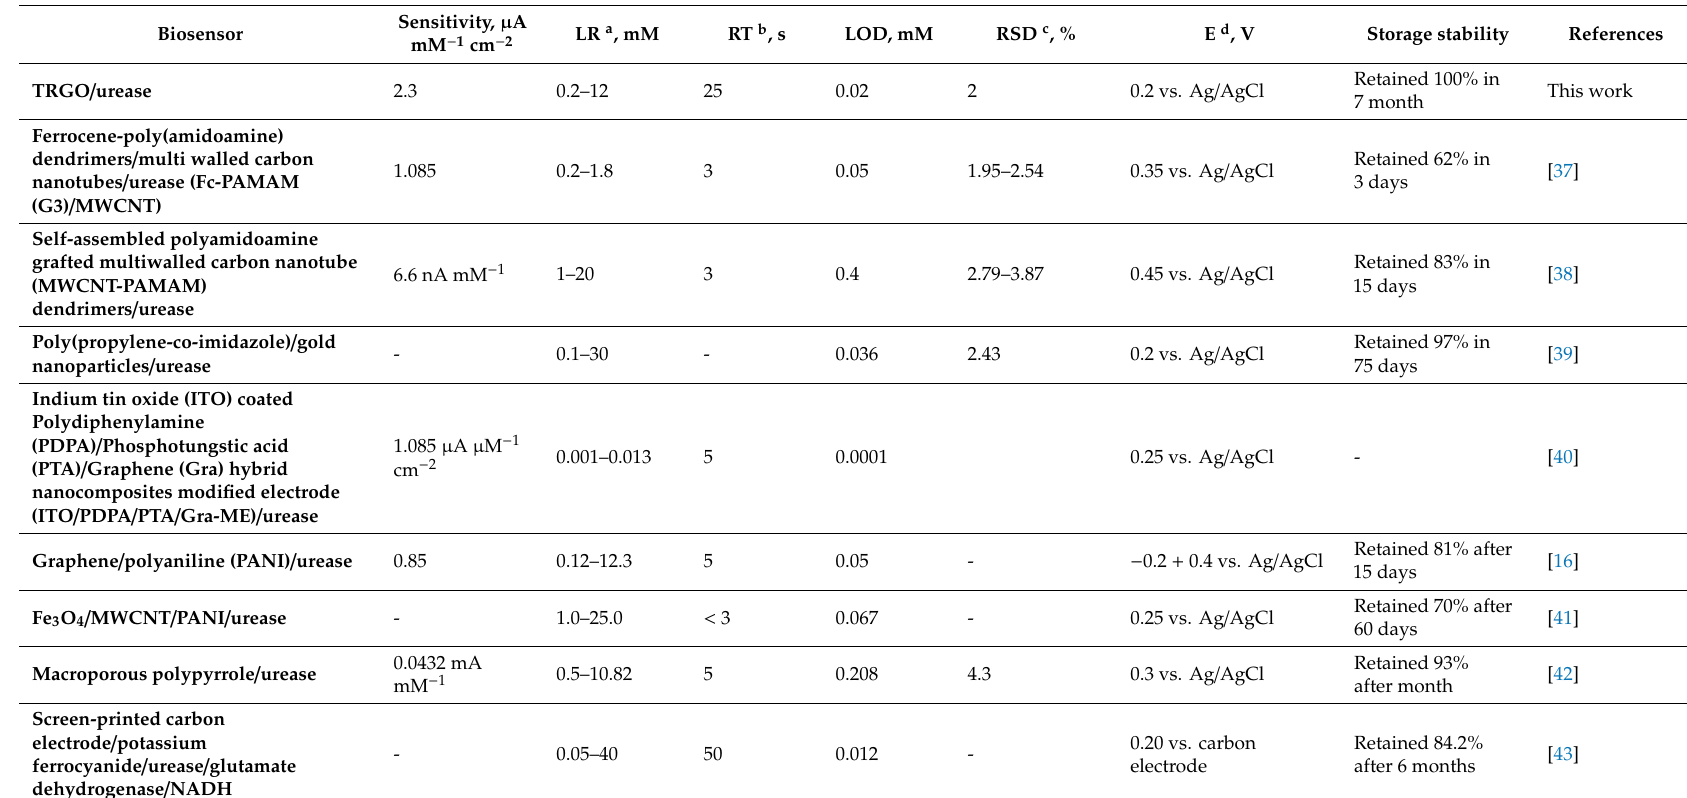
Table 2. Characteristics of recently reported urease using